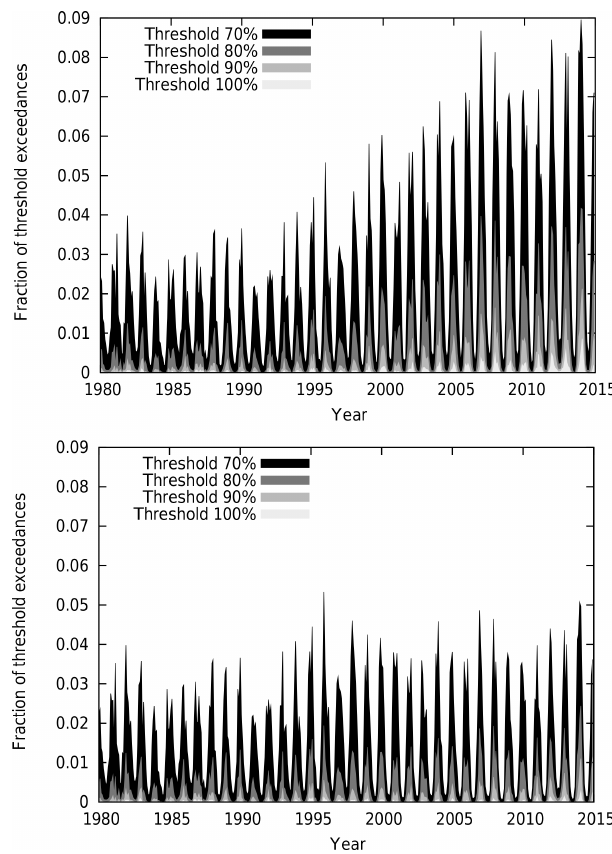
Figure 9. Raw time series of fraction of exceedances for UTHi thresholds from 70 to 100% before (top) and after (bottom) applica- tion of the cdf-based T 12 intercalibration for all satellites beginning from N15. The data until 1998 are identical in both panels. The raw time series after correction (bottom) does not show peculiar jumps and sudden increases